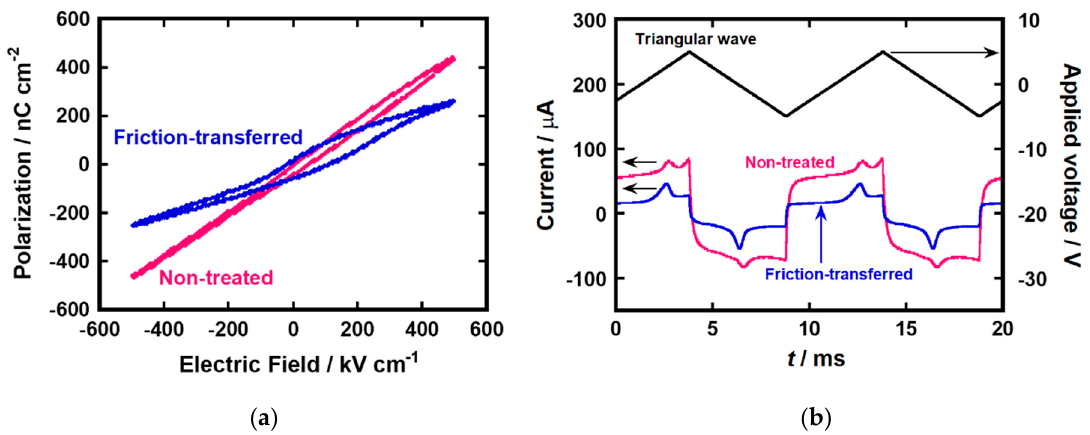
Figure 4. ( a ) Hysteresis loops and ( b ) polarization inversion current under the application of triangular wave for the spin-coated thin film of ( S ) − 1 deposited on non-treated and friction-transferred substrates in the SmC* phase at 100 °C.